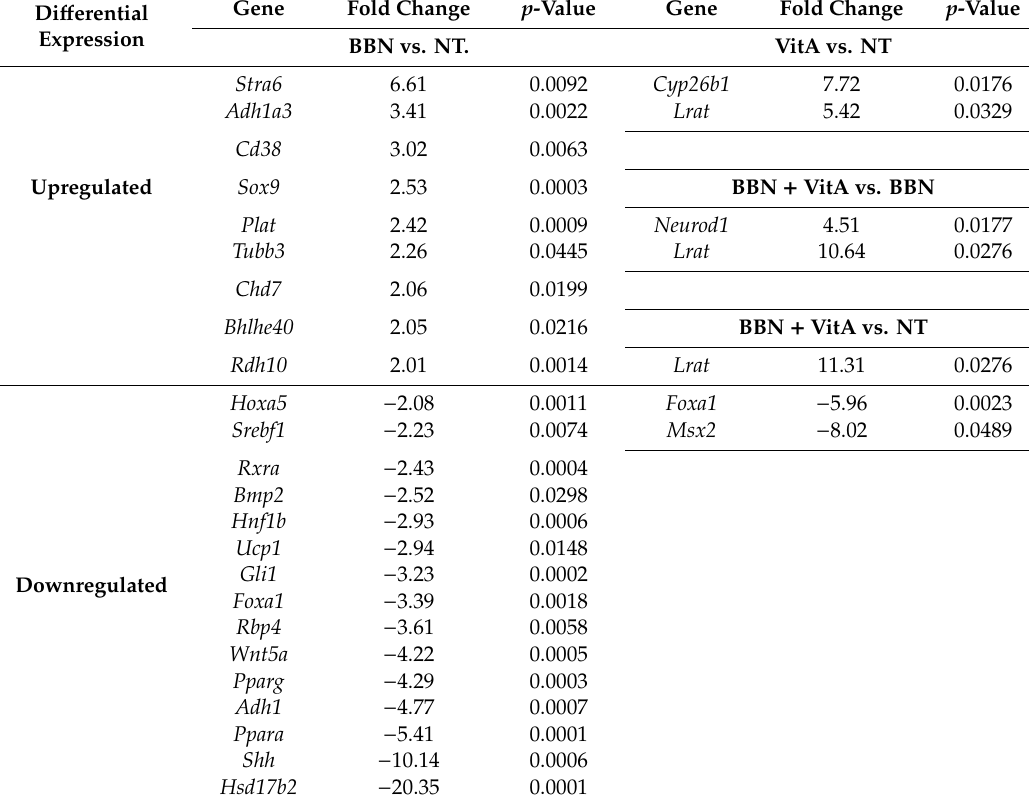
Table 1. Di ff erential expression of the genes involved in retinoic acid (RA) signaling in the mouse bladder tissue following BBN treatment and vitamin A rich diet. The list of top upregulated and downregulated genes from volcano plots with fold change higher than 2 or lower than − 2 and with p < 0.05 (comparisons between BBN and NT, BBN + VitA and NT, VitA and NT, and BBN + VitA and BBN are